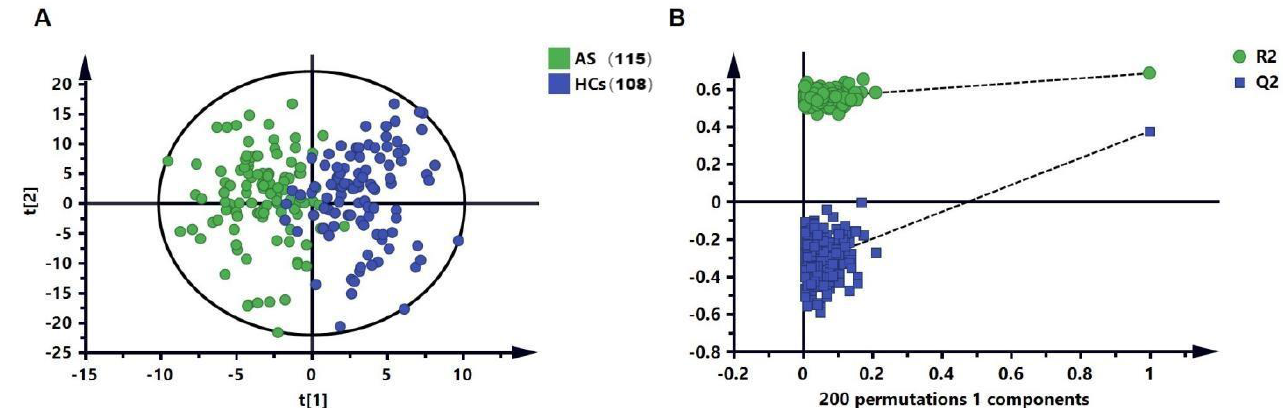
Figure 1. Design of this study.